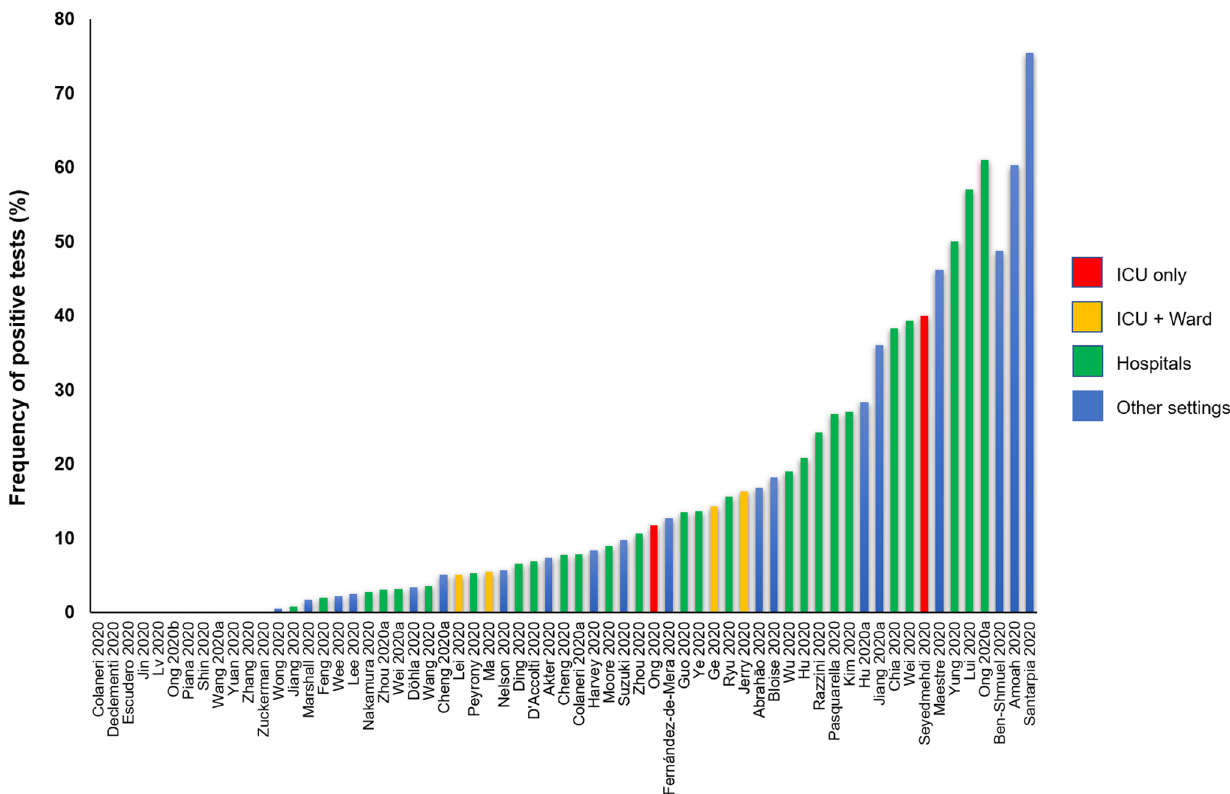
Figure 3. Rates of positive SARS-Cov-2 tests in studies assessing fomite